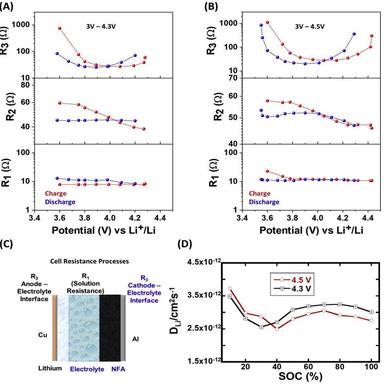
Electrochemical characteristics of NFA cathode material: (A) Various cell resistance processes at the different states of charge in the voltage window 3V–4.3V (B) cell resistance processes at the different states of charge in the voltage window 3V–4.3V, (C) Schematic representation of the resistances in the electrochemical cell and (D) Variation of diffusion coefficient with state of charge for the two voltage windows under investigation.